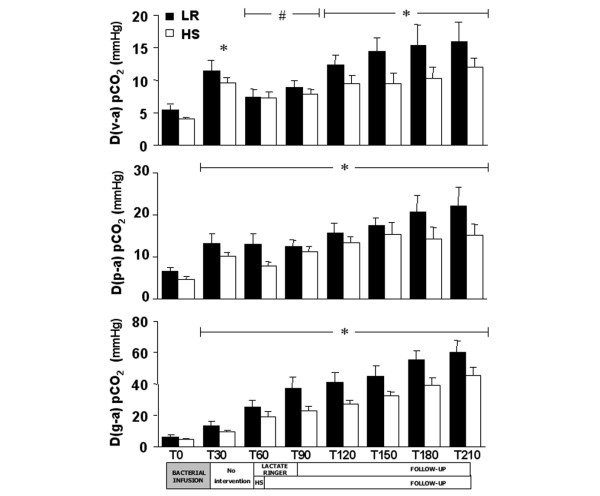
Venous-arterial pCO2 gradient (D(v-a)pCO2; mmHg, mean ± standard error of the mean (SEM)), portal-arterial pCO2 gradient (D(p-a)pCO2; mmHg, mean ± SEM) and gastric mucosal-arterial pCO2 gradient (D(g-a)pCO2; mmHg, mean ± SEM) during the experimental protocol. LR group received lactated Ringer's solution 32 ml/kg over 30 minutes, n = 7; HS group received 7.5% hypertonic saline solution 4 ml/kg over 5 minutes, n = 8. *p < 0.05 versus T0, both groups; # HS, p < 0.05 versus T0.